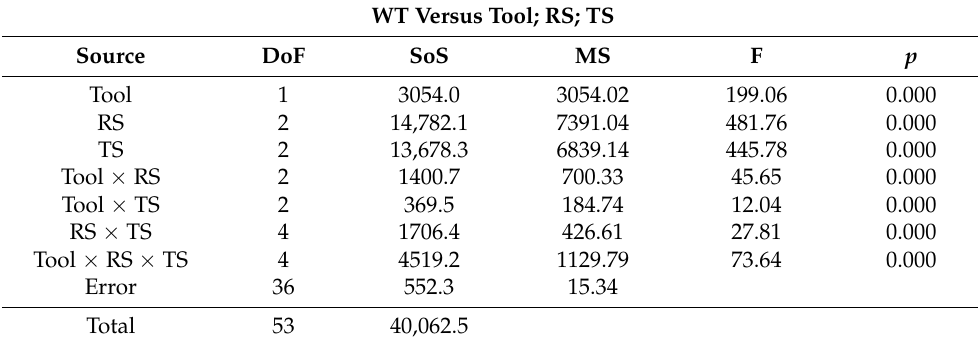
Table 3. Analysis of variance: general linear model (95% confidence